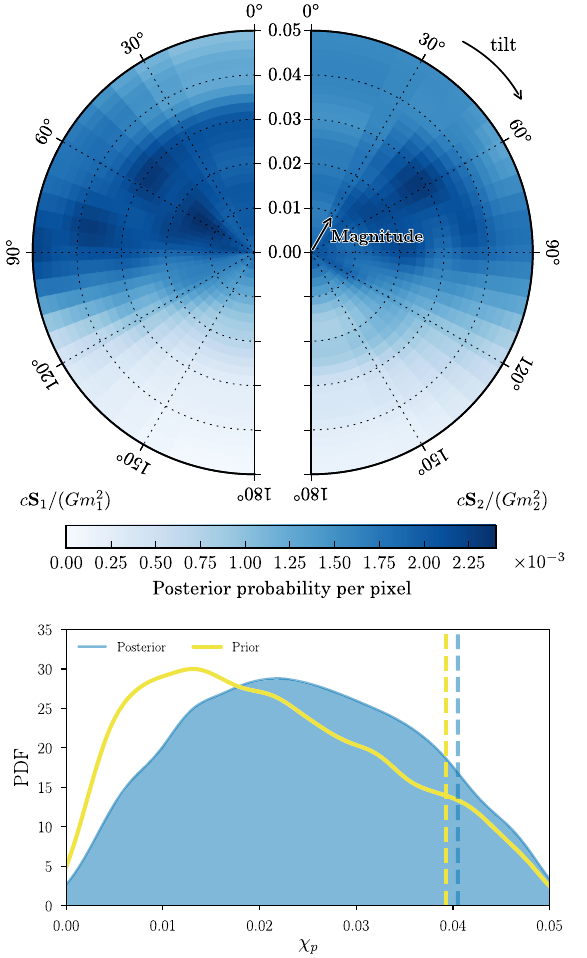
FIG. 9. Inferred spin parameters using the PhenomPNRT model as in Fig. 8, but in the low-spin case where the dimensionless component spin magnitudes χ < 0 . 05 . The pos- terior probability densities for the dimensionless spin compo- nents and for χ p are plotted at the reference gravitational-wave frequency of f ¼ 100 Hz.